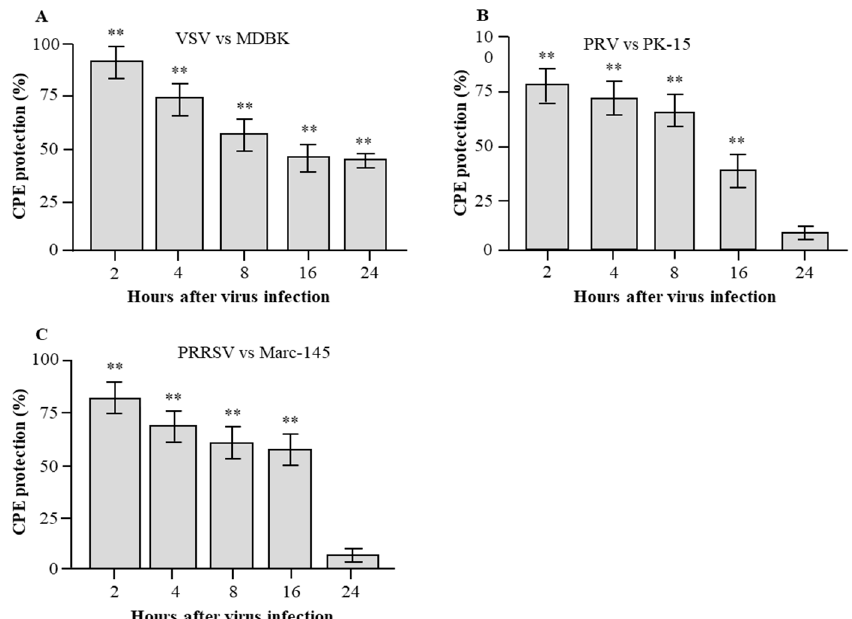
Figure 6. Detection of post-infection antiviral activities of rPoIFN- β . Three cell lines MDBK cells ( A ), PK-15 cells ( B ) and Marc-145 cells ( C ) were infected with the indicated viruses VSV ( A ), PRV ( B ) or PRRSV ( C ) and then treated with a fixed concentration of rPoIFN- β . At different time points post infection, the post-infection antiviral activities were measured in triplicates by CPE inhibition assay. ** indicates significant difference ( p < 0.01) in CPE protection of rPoIFN- β as compared with the virus control (VC).